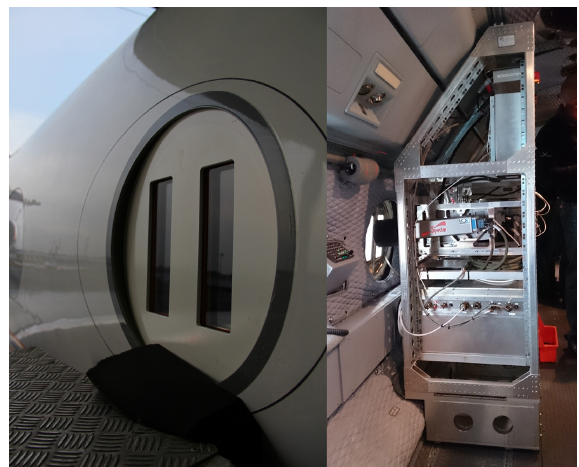
Figure 20. specMACS mounted on the HALO aircraft equipped with the side view